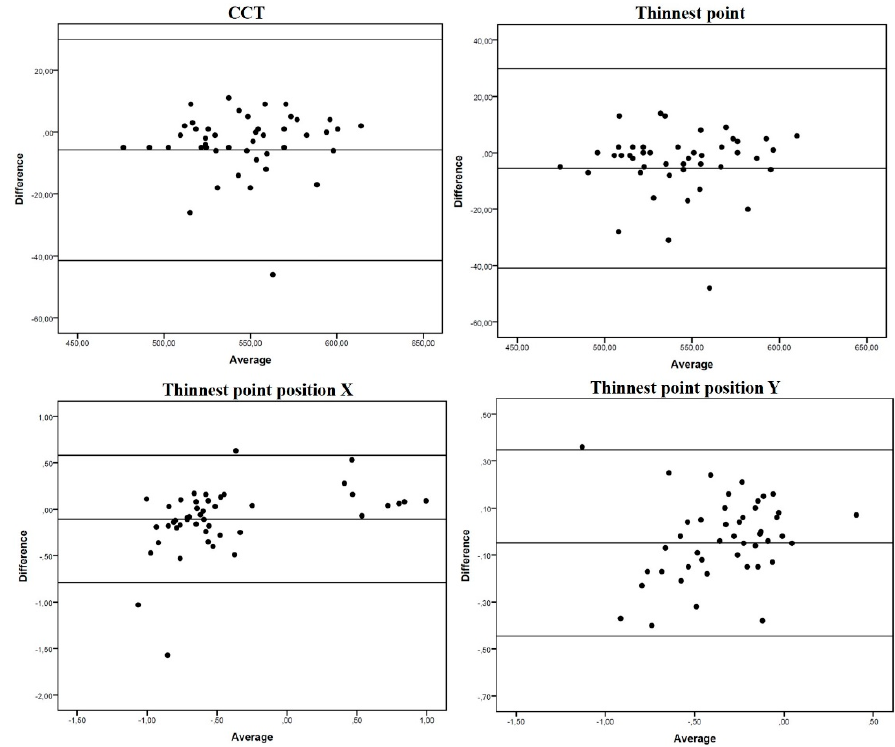
Figure 2. Bland-Altman plots of mean differences against averages of pachy-metric measurements. Mean, lower and upper limits of agreement (±1.96 SD, standard deviation).